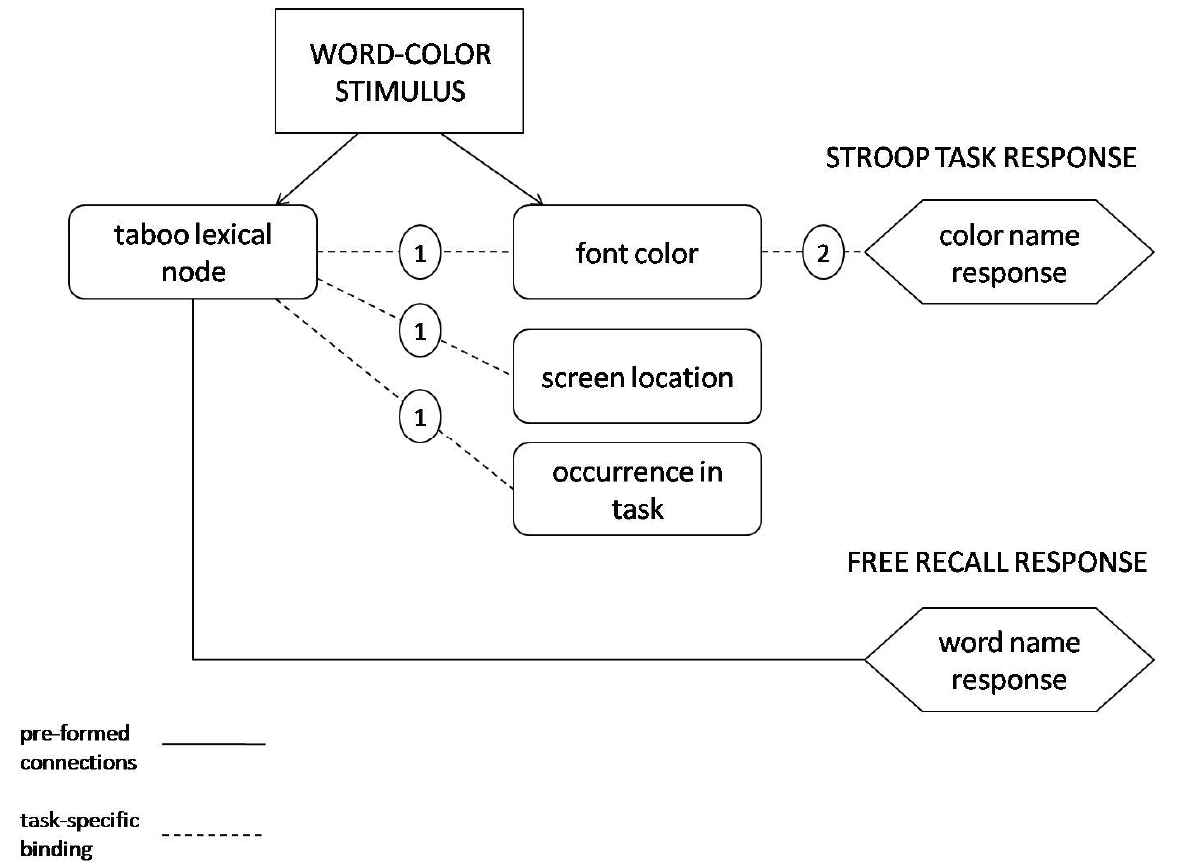
Figure 1. Links involved in naming the font color of taboo words and recalling their occurrence-in-the-task under binding theory. When a taboo word-color stimulus is presented, preformed connections (solid lines) enable activation of two nodes: the lexical node for the taboo word and a node representing its font color. Binding processes then form four task-specific links (broken lines): a link between the font color and the lexical node for the taboo word, a link between the font color and the color-naming response, a link between the lexical node for the taboo word and its screen location, and a link between the lexical node for the taboo word and nodes representing its episodic occurrence in the task. The circled numbers indicate the order of occurrence of these binding processes. Note that under the priority binding principle, font color first becomes bound to the taboo lexical node (1) and then to the color-naming response (2), which is the basis for taboo Stroop interference under binding